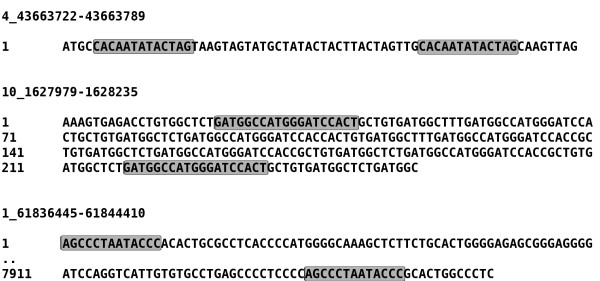
Microhomologies detected in sequenced SVs. Shown are the three SVs in which microhomology (grey boxes) was detected at the SV breakpoints.